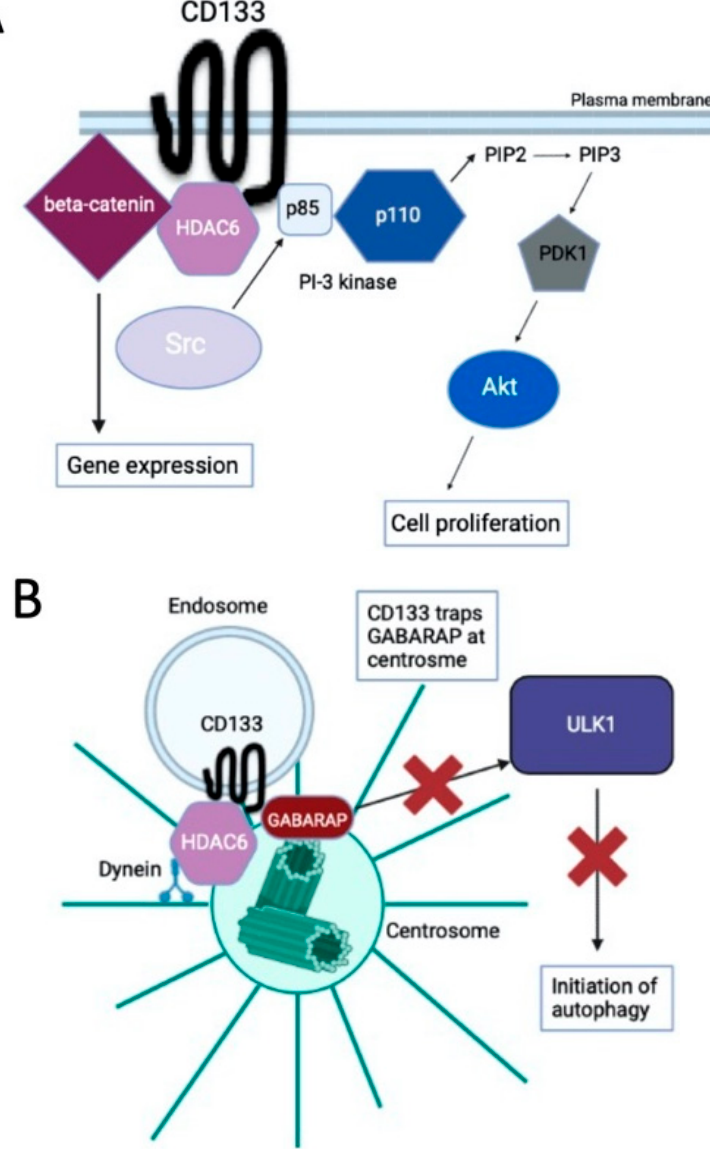
Figure 1. The signal transduction pathway of CD133. ( A ) CD133 is phosphorylated in its intracellular C-terminal domain by Src family tyrosine kinases, resulting in the binding and activation of the p85 subunit of phosphoinositide 3-kinase (PI-3K). Activated PI-3K then signals downstream targets such as Akt to promote cell proliferation. CD133 is also stabilized by binding to histone deacetylase 6 (HDAC6), which increases the transcriptional activity of β -catenin, promotes cell proliferation, and inhibits cell differentiation. ( B ) Under conditions in which Src family kinases are inactivated, unphosphorylated CD133 is transported from the plasma membrane to intracellular regions via en- docytosis. After endocytosis, CD133 endosomes are transported along microtubules to centrosomes,